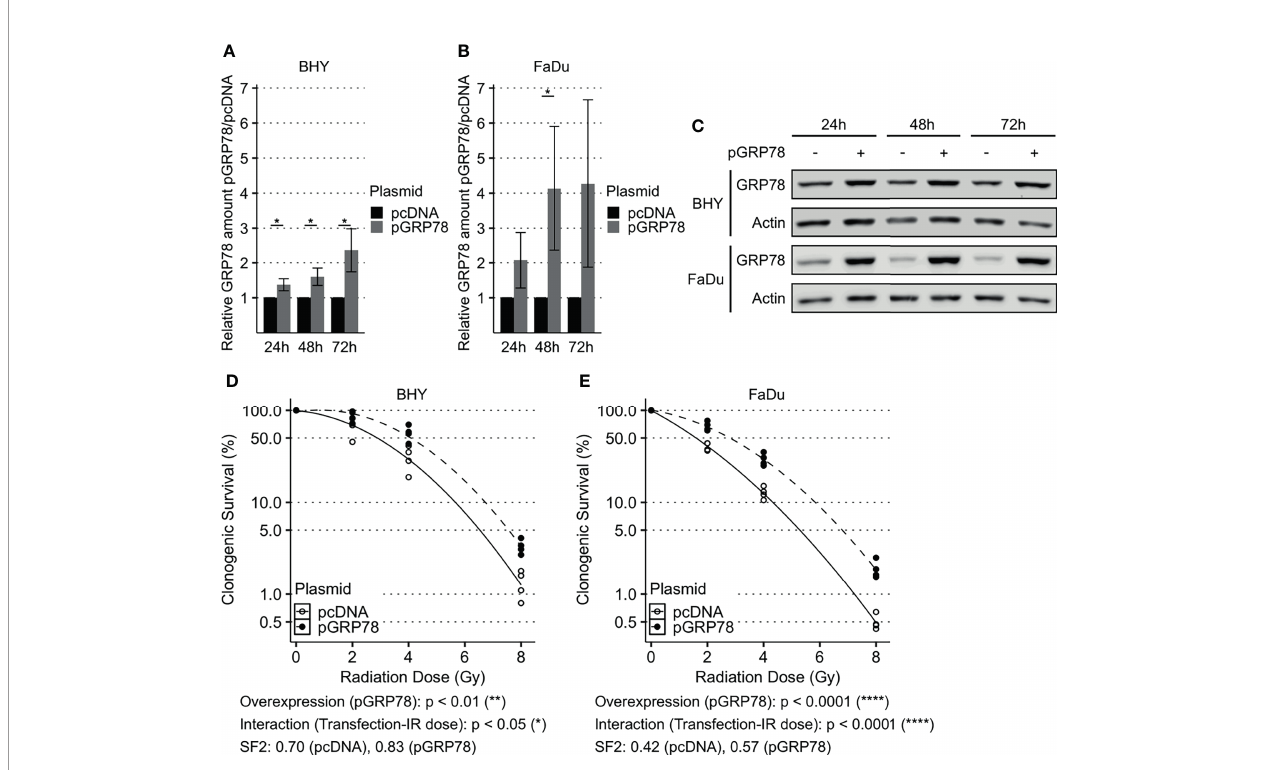
FIGURE 3 | Enhanced survival of irradiated HNSCC cells after overexpression of GRP78. (A – C) Western Blot analysis of GRP78 shows increased expression in BHY (A) and FaDu (B) cells 24 h, 48 h and 72 h after transfection with GRP78 plasmid (pGRP78). GRP78 expression was normalized to beta-actin and control transfection (pcDNA) served as baseline (n = 4, 2-way RM ANOVA, *p adj. < 0.05). (C) Representative Western Blot images of GRP78 expression in pGRP78- and pcDNA-transfected BHY and FaDu cells. Beta-actin was used as loading control. (D, E) Clonogenic survival assay of BHY (D) and FaDu (E) cells exposed to radiation doses of 0, 2, 4 or 8 Gy 72 h after GRP78 transfection. Both cell lines show increased survival in GRP78 overexpressing cells. Values were normalized to 0 Gy control. Logarithmic scale was used for the relative cell survival (n = 4, Two-way RM